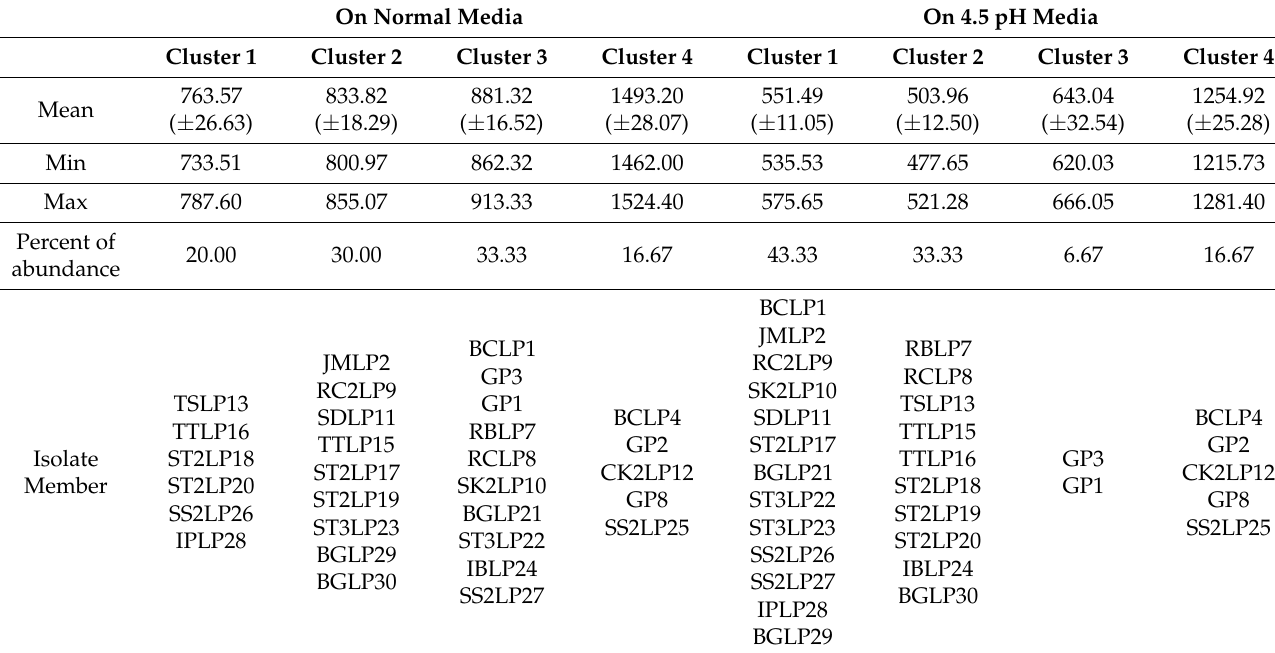
Table 4. Distribution of lateritic Pseudomonads and associated isolates, based on k mean cluster analysis of the average vigour